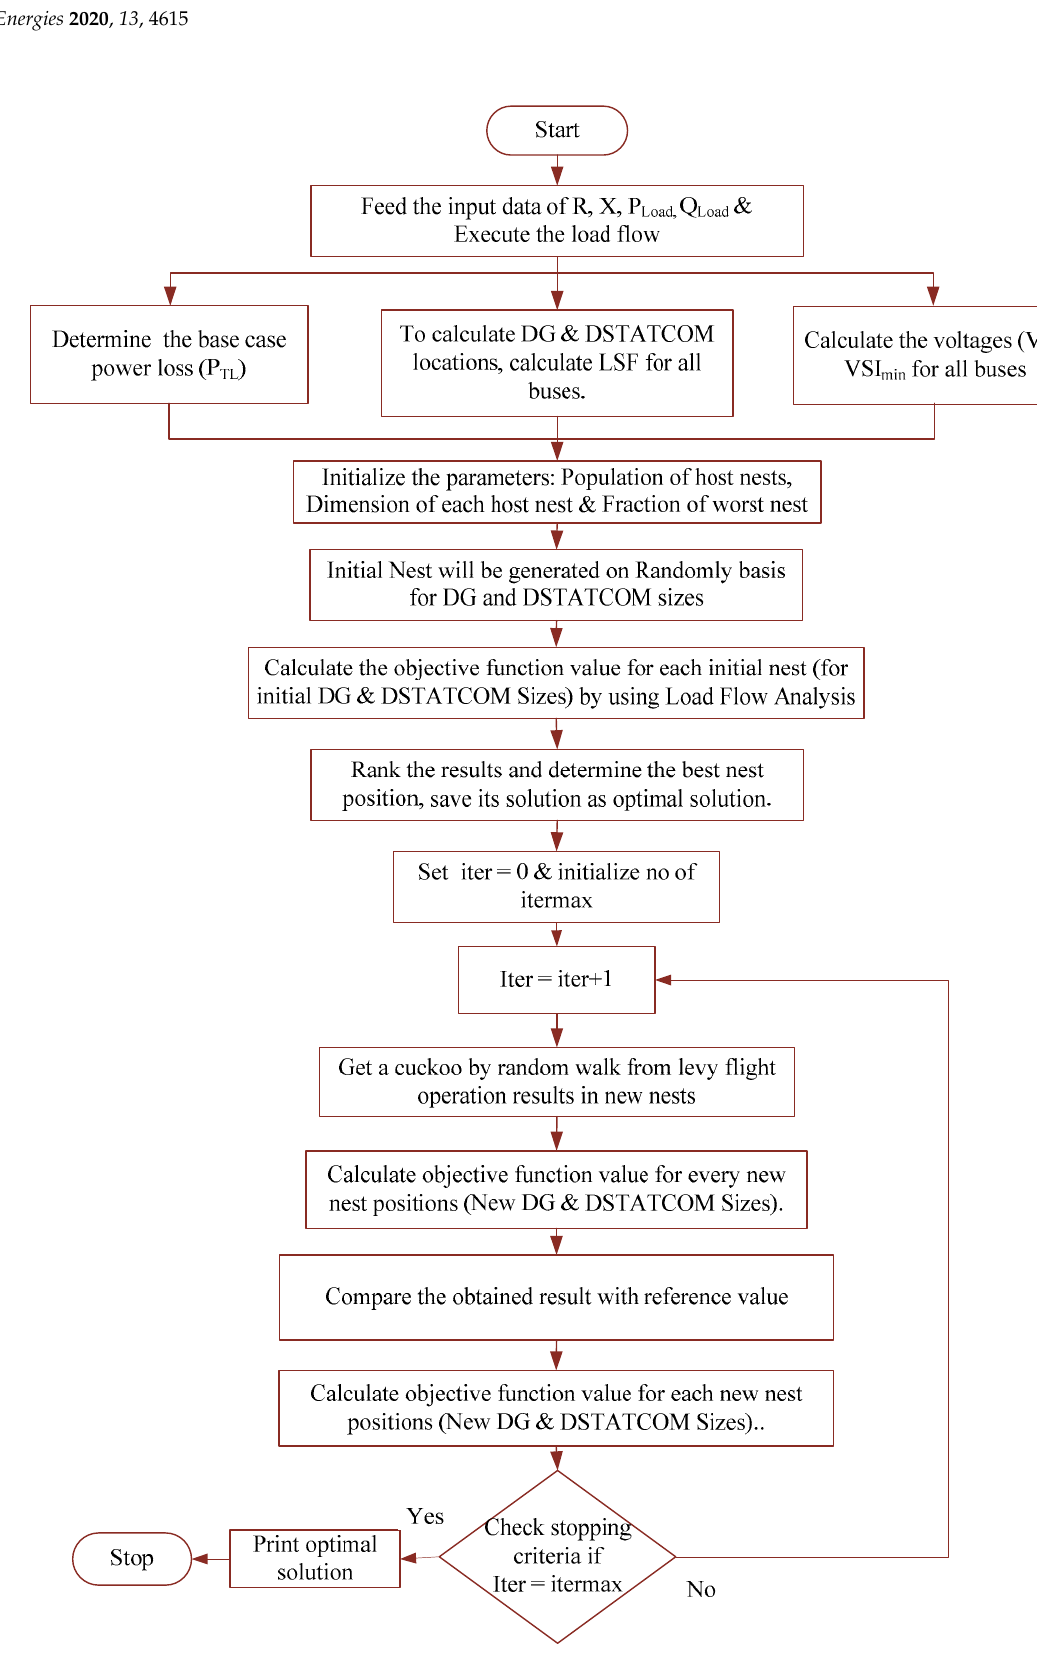
Figure 2. Flow Chart of CSA.